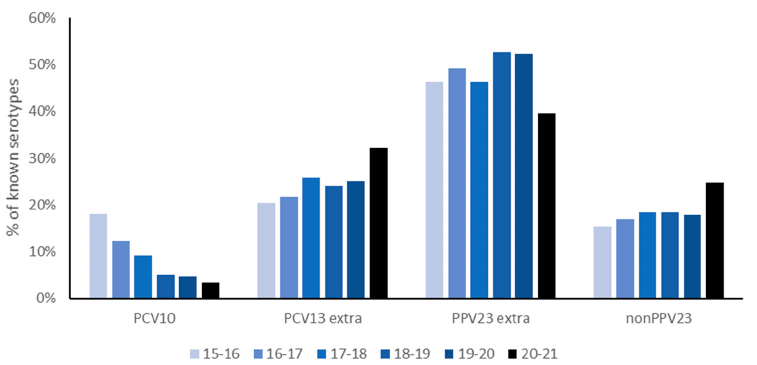
Figure 3. Percentage of IPD cases caused by vaccine serotypes during the years 2015–2021, in all age groups except those aged 73–79 years old.